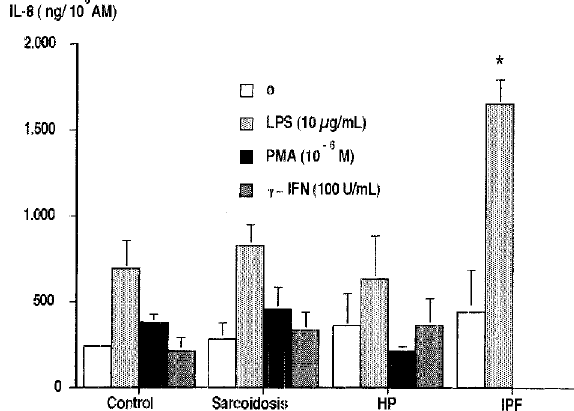
FIG. 5. Interleukin-8 secretion in the different experimental groups. Statistical study of the effect of the different stimuli on IL-8 secretion by AMs revealed significant differences (Wilcoxon test) between basal and LPS-stimulated secretion ( P <0.001) or secretion stimulated by PMA ( P =0.004). No significant differences between basal and interferon-induced secretion were observed. On comparing LPS-induced secre- tion and that induced by PMA, statistically significant differences were found (Wilcoxon test, P =0.004). Compar- ison of the different groups revealed significant differences in LPS-stimulated secretion ( P =0.025). These differences were observed between the patients with IPF and the other groups (Fisher PLSD test P <0.05). Definition of abbreviations: AM = alveolar macrophage, HP = hypersensitivity pneu- monitis, IPF = idiopathic pulmonary fibrosis, IFN = interferon, IL = interleukin, LPS = lipopolysaccharide, PMA,